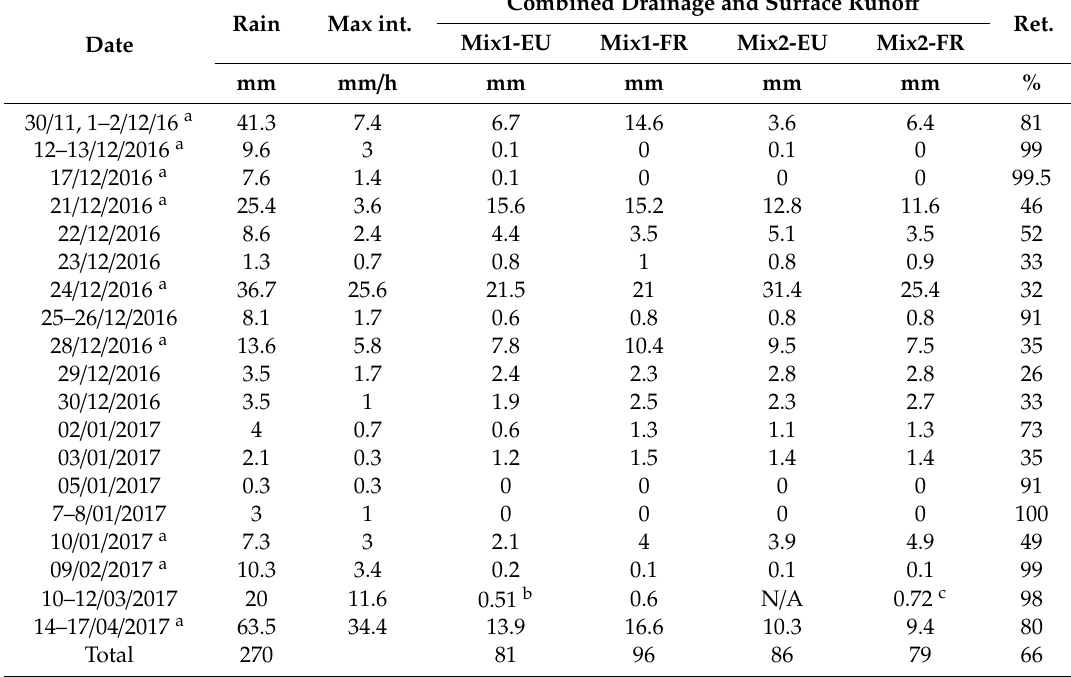
Table 2. Rain; maximum 15-minute rainfall intensity (Max int.); combined drainage and surface runoff (average of four replicates) for four green roof treatments, consisting of two substrate mixtures (Mix1, Mix2) and two plant species (EU = E. veneris , FR = F. Laevis ); and average retention (Ret.) of the 16 test beds, for all rainfall events with drainage between 1 February 2016 and 30 April 2017 (total rain 371 mm). Rain Max